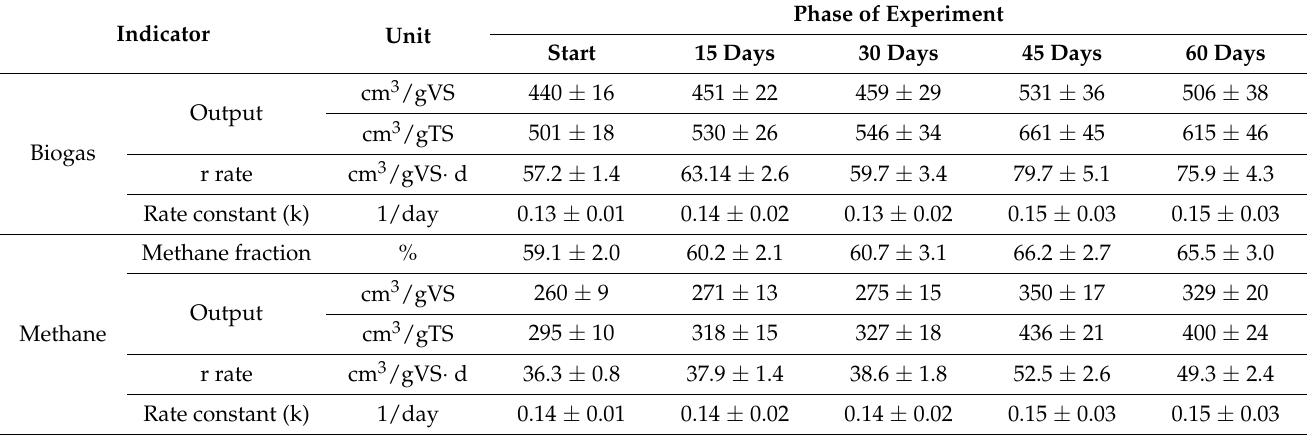
Table 6. Indicators of hydrophyte biomass AD